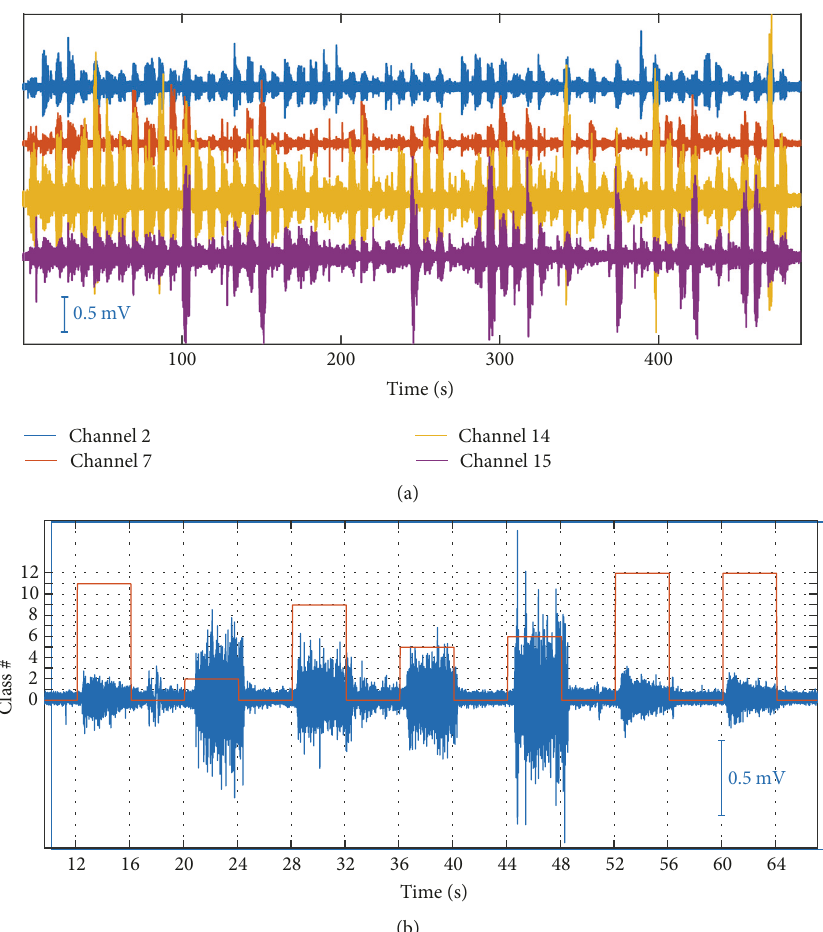
Figure 2: (a) shows sample EMG channels (2, 7, 15, and 15). (b) shows only channel 7 raw EMG signal (blue) with the visual cues/classes (red). This figure is an example of the latencies between visual cue and the EMG onset. This is also noticeable for the movement endings which are delayed with respect to the visual cue. Another important piece of information presented in this figure is similarity between EMG waveforms for the same movements (i.e., class